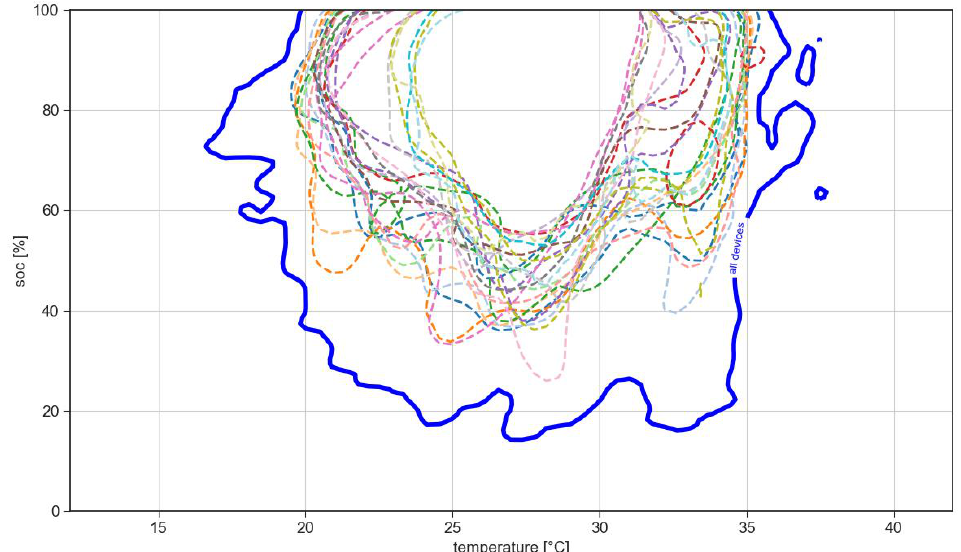
Figure 8. Available data for each vehicle individually (dashed lines) and for the whole fleet (blue line).